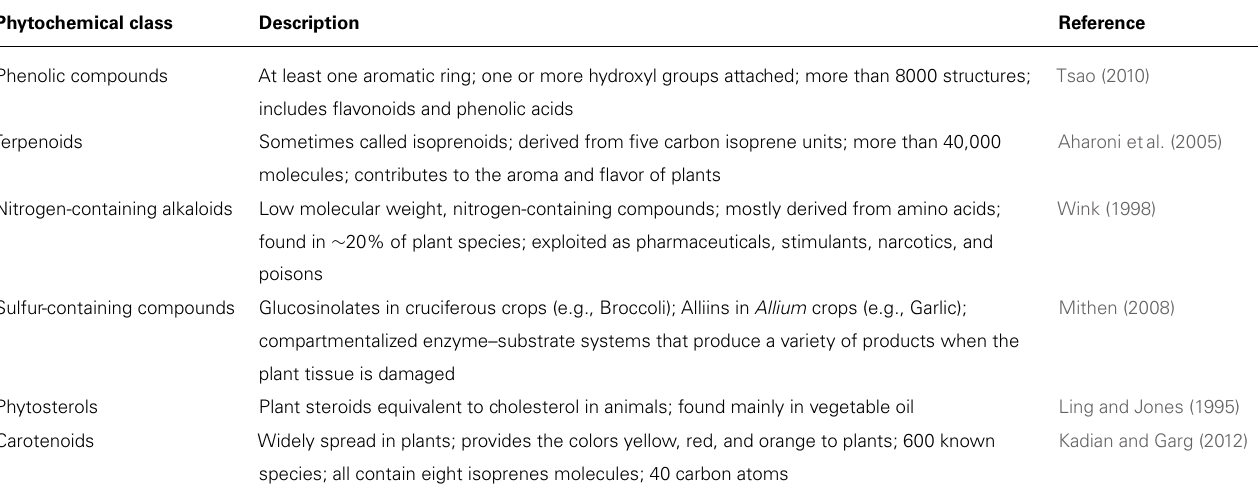
Table 1 |The different classes of